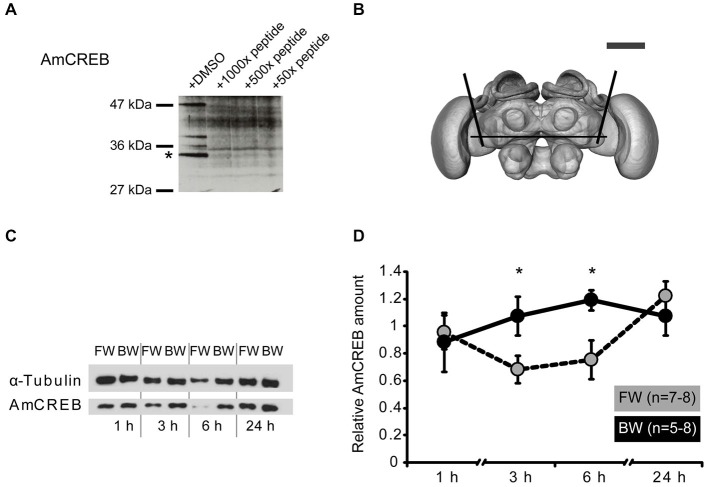
The amount of AmCREB protein changes after conditioning. (A) Peptide competition assay to test the specificity of the anti-human CREB antibody (see methods) used in this study. Before incubating a western blot of honeybee brain homogenate with an anti-human CREB antibody the antibody was preincubated with a 1000x, 100x, and 50x molar excess of a peptide from the C-terminus of AmCREB. This peptide is homologous to the antibody’s human epitope. Bands disappearing following the AmCREB peptide preincubation are regarded as AmCREB proteins. The 33 kDa band (marked with a star) is analyzed in the subsequent experiments. Left: Size of the prestained protein marker. (B) The central part of the bee brain was analyzed (picture taken from the honeybee standard atlas, http://www.neurobiologie.fu-berlin.de/beebrain/DownloadGeneral.html) (Brandt et al., 2005). Black lines delimit the dissected part. Scale bar ~300 μm (gray line). (C,D) Two groups of honeybees were conditioned with either three forward trials (FW, gray) or three backward trials (BW, black). The forward conditioned animals were selected according to a conditioned response (CR) in the third trial. The brains were dissected at 1 h, 3 h, 6 h and 24 h after conditioning and probed for their relative amount of AmCREB. (C) Representative western blot for the FW and BW at the respective time points. Following protein separation and blotting, the membrane was cut at approximately 50 kDa horizontally in two. The upper part (>50 kDa) was probed with the anti-α-tubulin antibody and the lower part (<50 kDa) with the anti-CREB antibody. (D) Quantification of the relative amount of AmCREB shows a decreased AmCREB amount 3 h and 6 h after conditioning in the FW group compared to the BW group. The asterisks indicate the significant differences (p < 0.05).